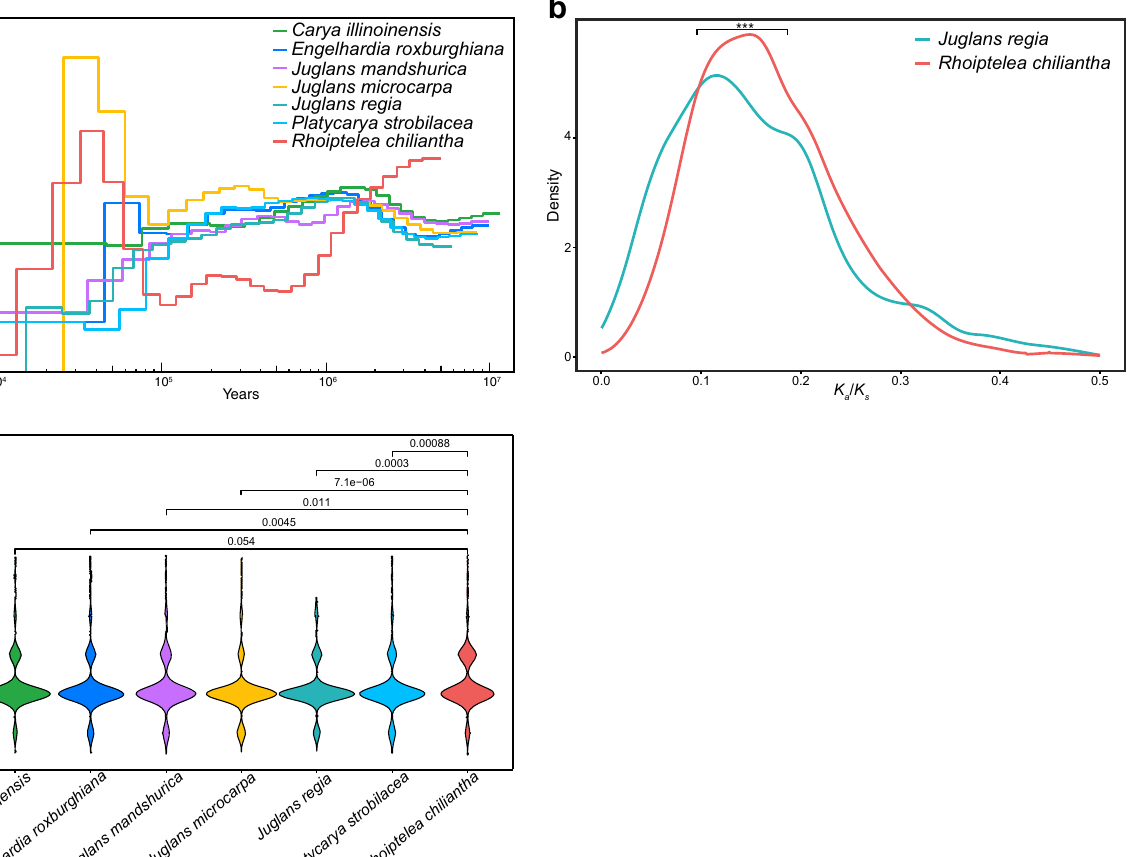
(Mann – Whitney test) was performed on the K a / K s distributions. *** P <0.001. c Violin plots of the number of genes in gene families associated with DNA repair test between R. chiliantha and other species. Source data are provided asa Source Data fi